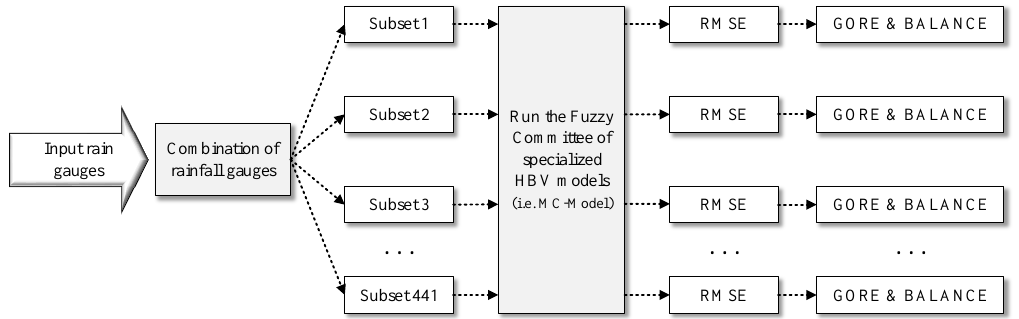
Table 5. Number of possible combinations or subsets using different number of rainfall gauges.